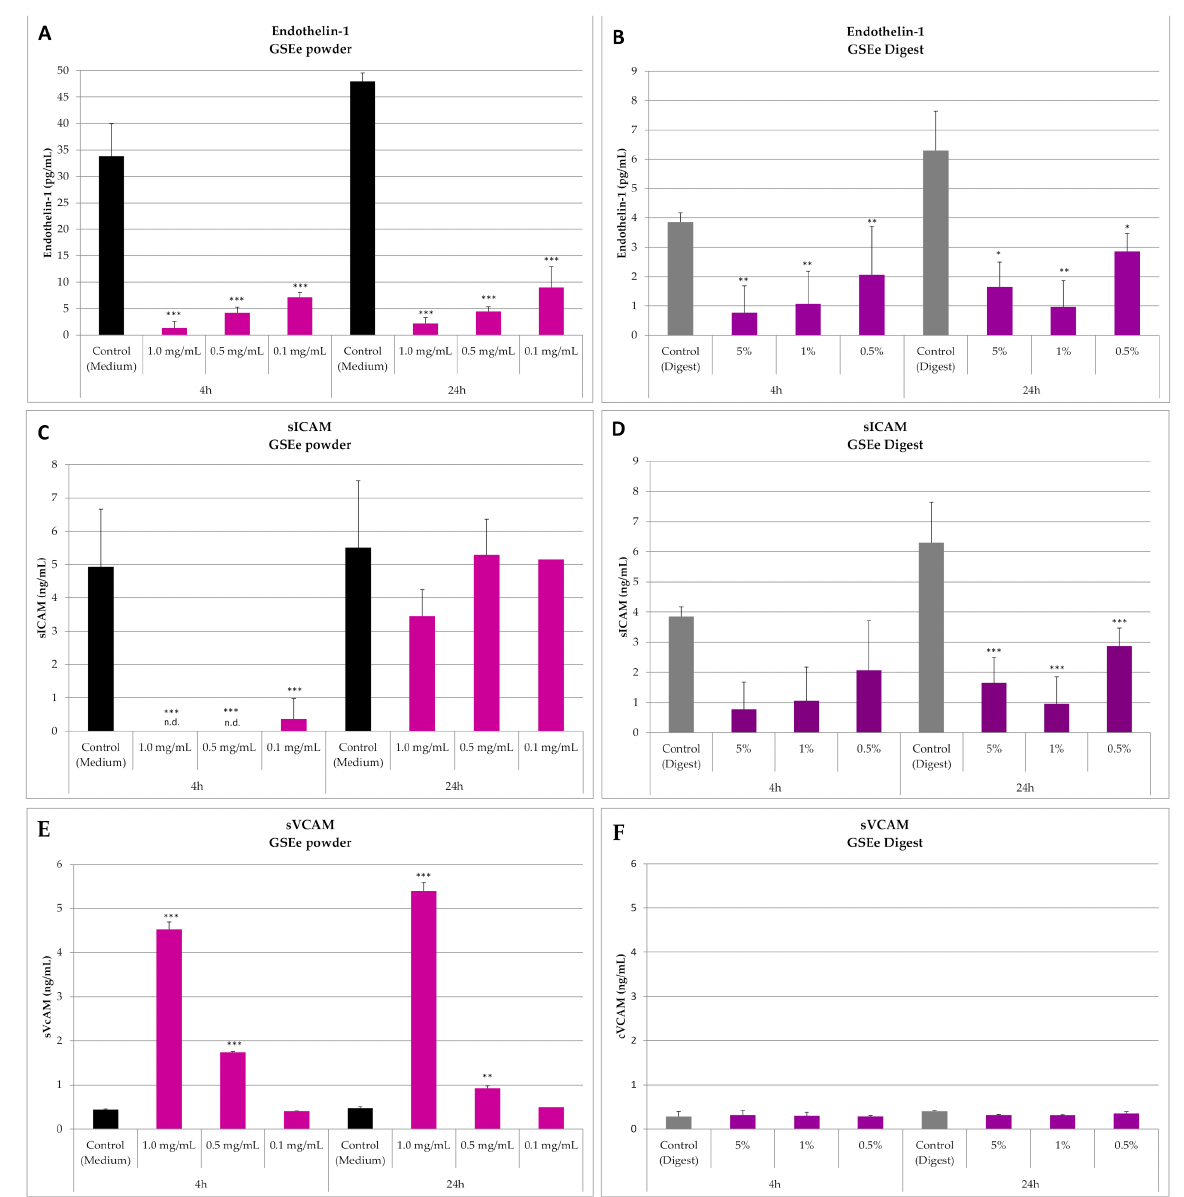
Figure 2. Effect of GSEe powder and GSEe digest on endothelin-1, sICAM and sVCAM secretion after 4- and 24-h incubation. In Figures 2A, 2C and 2E, the detection after GSEe powder administration; in Figures 2B, 2D and 2F the detection after GSEe digest administration. ( A , B ): endothelin 1; ( C , D ): sICAM; ( E , F ): sVCAM. Values are given as mean ± SD, n = 6, n.d. =